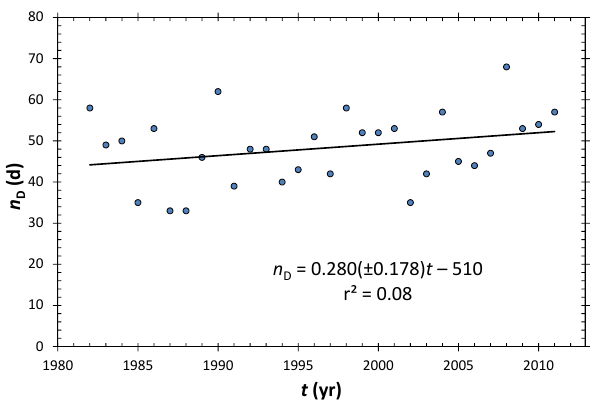
Fig. 6. Number of days per year n D with at least one continen- tal USA severe tornado (path length L ≥ 10km) is given for the time period 1982–2011. The best-fit linear correlation is also given (Eq. 4), with uncertainties given as ±1s.e. (standard error) of the slope. Tornado path length data L are from NOAA